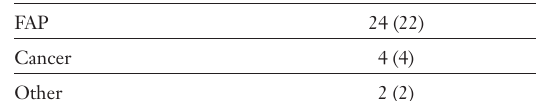
Ileal pouch-anal anastomosis: indica- tions for